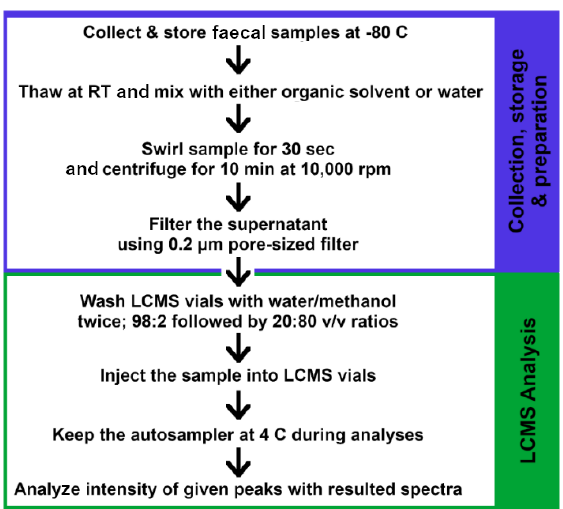
Figure 6. A summarized protocol for LC – MS analysis for human gut